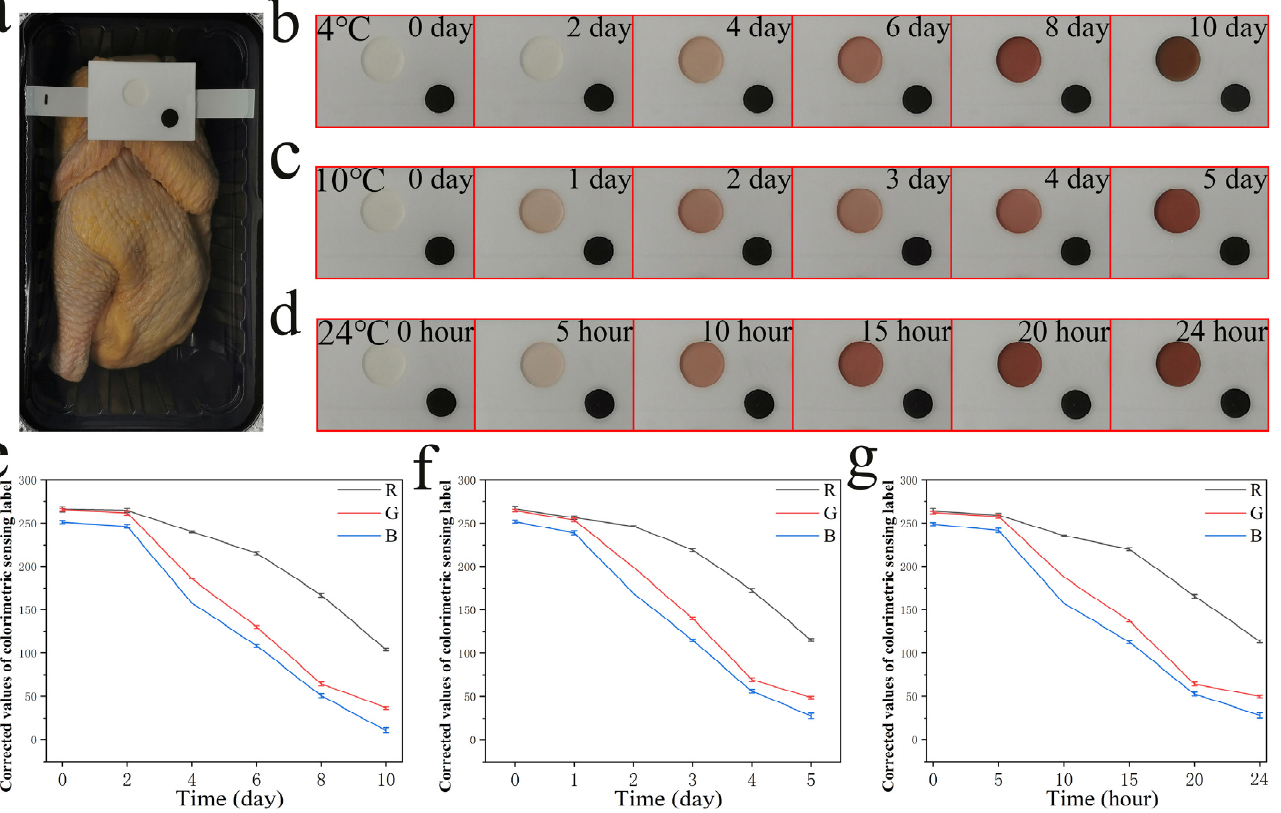
Figure 5. ( a ) The schematic of the modified atmosphere packaging (MAP: 20% CO 2 , 80% N 2 ), ( b – d ) color change in colorimetric sensing labels in chilled broiler meat wrapped in modified atmosphere packaging at different temperatures ( b ): 4 °C, ( c ): 10 °C, ( d ): 24 °C); ( e ) R , G , and B values of colori- metric sensing label at 4 °C; ( f ) R , G , and B values of colorimetric sensing label at 10 °C; ( g ) R , G , and B values of colorimetric sensing label at 24 °C.